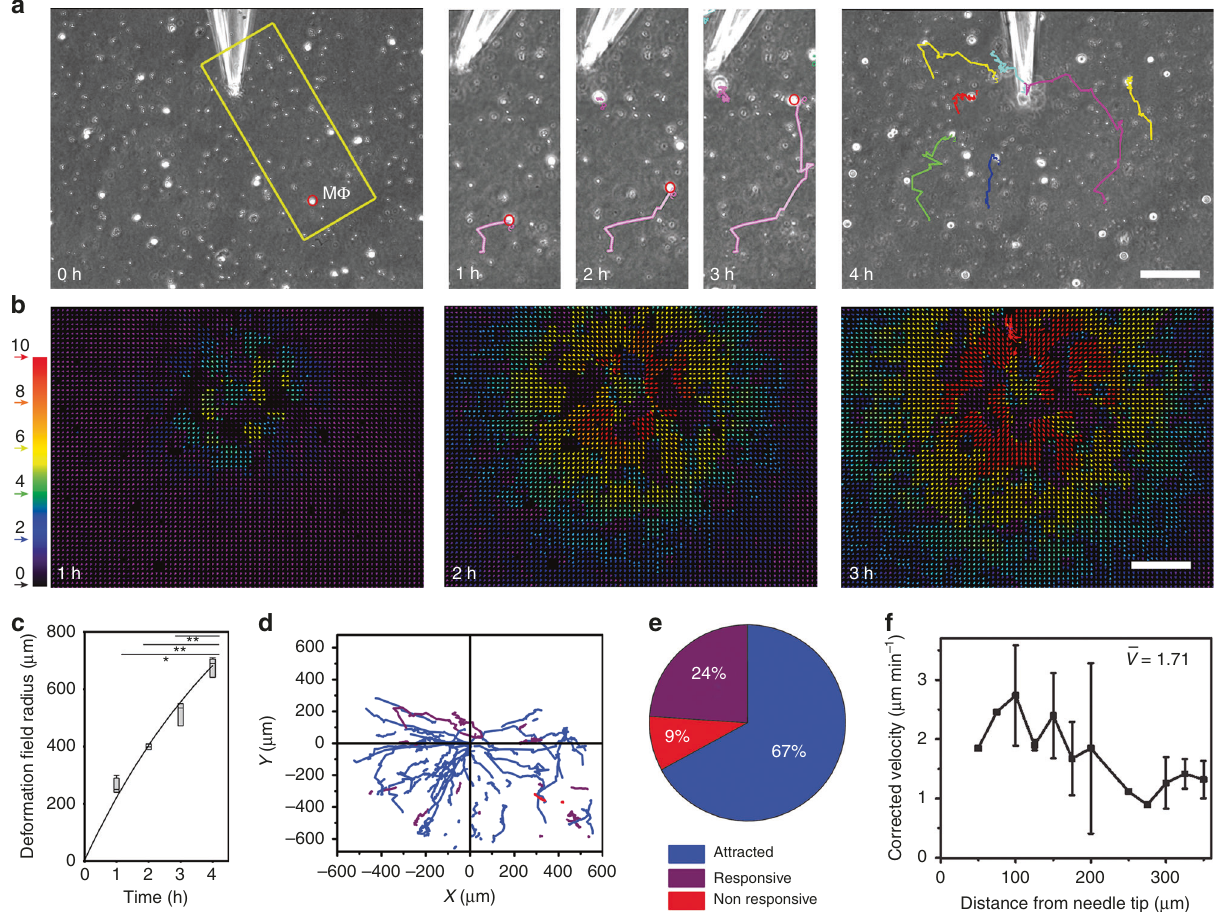
Fig. 5 Macrophages (M ϕ ) are attracted by local pulling events in collagen extracellular matrix (ECM). a M ϕ were seeded onto collagen ECM with surface marker beads without myo fi broblast (MF) but with microneedles inserted 5 µ m into the 200- µ m-thick collagen gel. Lateral collagen deformation, mimicking MF contraction, was achieved by sucking collagen fi bers into the tip using negative pressure. M ϕ migration was tracked from phase contrast movies. b Color-coded vector maps were obtained from particle image velocimetry (PIV) of bead displacements to represent the induced deformation fi elds as indicated (red — high displacement). c Deformation fi eld radii of microneedle-induced deformation fi elds are plotted over time and shown as medians (center lines) of box (25th to 75th percentiles) and whisker (minimum to maximum) plots (* p < 0.05 and ** p ≤ 0.01 using analysis of variance followed by post-hoc Tukey ’ s multiple comparison test). d M ϕ trajectories are plotted over 4 h with respect to the position of the microneedle (0,0) and e classi fi ed into attracted, responsive, and non-responsive M ϕ . f Median values of the dragging-corrected velocities of attracted M ϕ are plotted as a function of distances to the microneedle tip. Error bars represent the minima and maxima, 111 M ϕ , 12 independent experiments. Only experiments were considered for analysis where collagen created a tight seal with the tip and suction did not induce any fl ow, as controlled by fl uorescent particles added to the culture medium. All scale bars: 100 µ